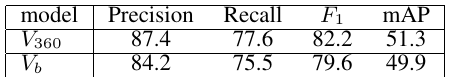
Table 4. Precision, Recall, F 1 score and mAP for the binary masks predicted on the the UAV 360 dataset by the variant V 360 of our method and the baseline V b .